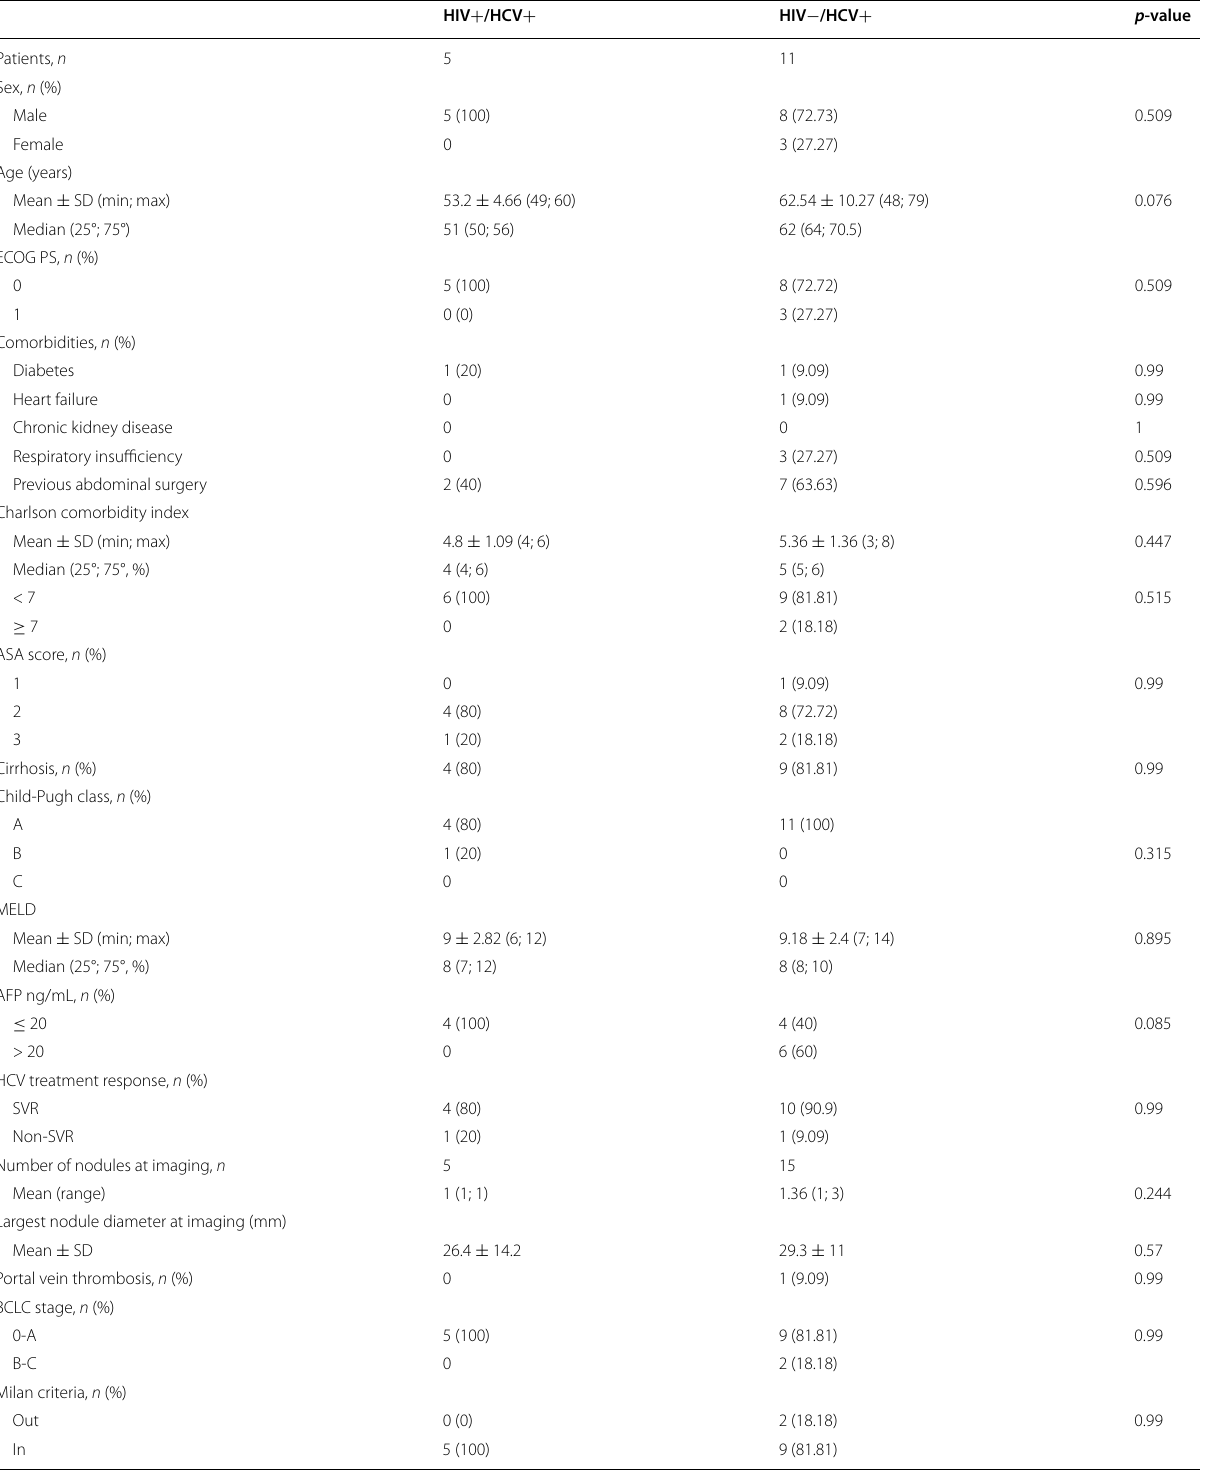
Table 1 General clinical features of enrolled